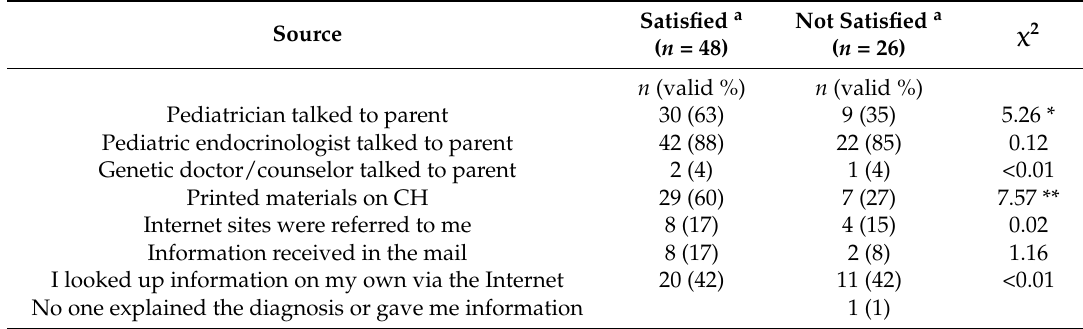
Table 5. Sources of education for parents satisfied with the information that they received compared to parents that would like to have received more information about their child’s CH